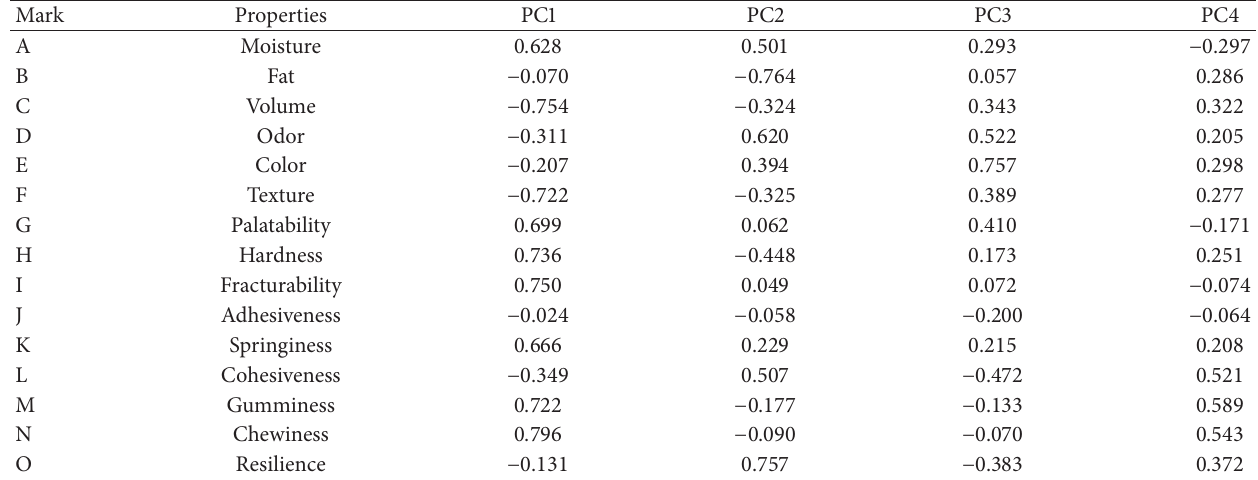
Table 8: Eigenvalues for principal components for all the parameters of fried fritters.